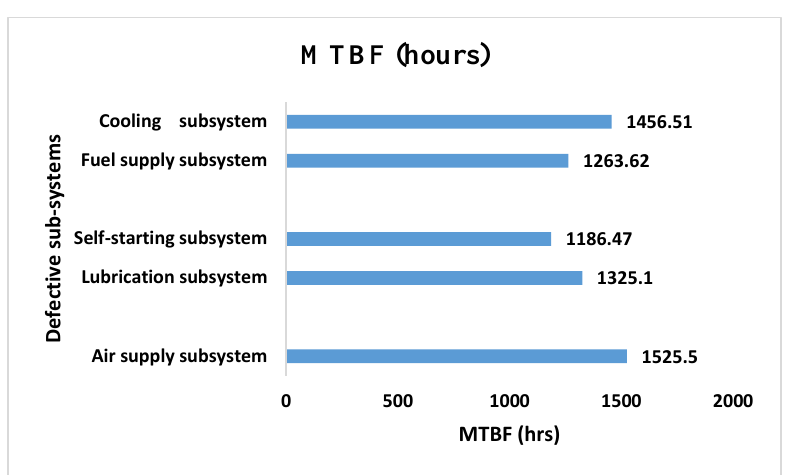
Figure 6. Reliability for five subsystems.